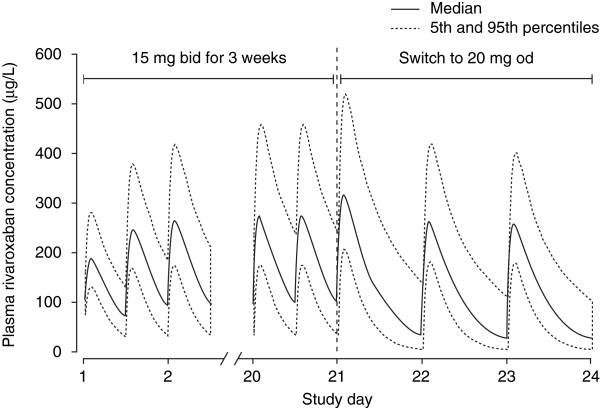
Simulated venous thromboembolism treatment dosing regimen of rivaroxaban. Regimen is 15 mg bid for 3 weeks followed by 20 mg od (n=870) [12]. bid, twice daily; od, once daily. Reproduced from Mueck W, Lensing AW, Agnelli G et al. Rivaroxaban: population pharmacokinetic analyses in patients treated for acute deep-vein thrombosis and exposure simulations in patients with atrial fibrillation treated for stroke prevention. Clin Pharmacokinet 2011; 50:675–686 with permission from Adis (© Springer International Publishing AG 2011. All rights reserved).